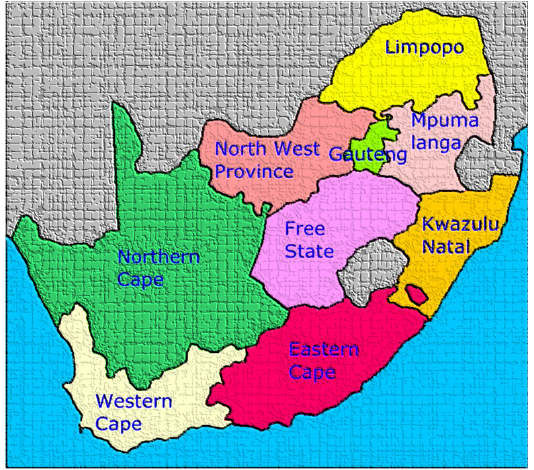
Figure 1. Map of South Africa showing the Eastern Cape Province.